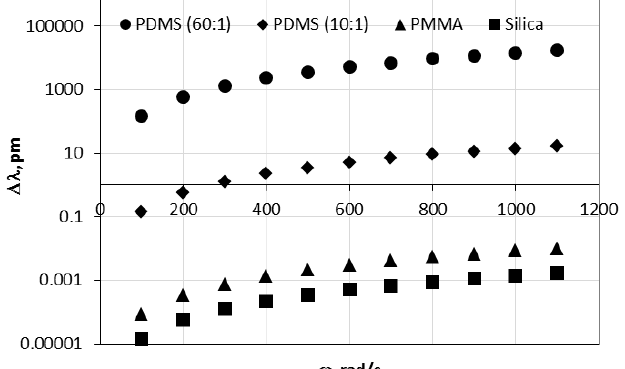
Figure 4. MDR shift using Equation (7) for silica, PMMA and PDMS 10:1 and 60:1